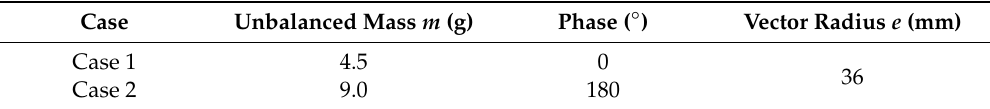
Table 5. Unbalanced mass and its position used for the balancing test.